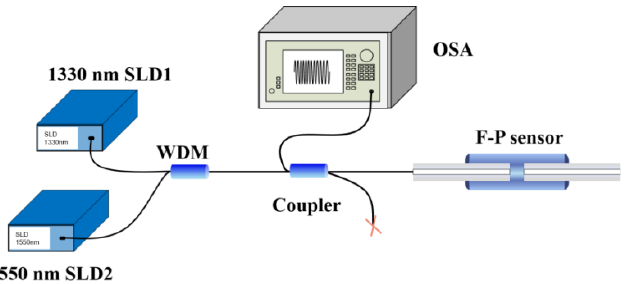
Figure 1. Schematic diagram of a typical fiber-optic F–P sensor.